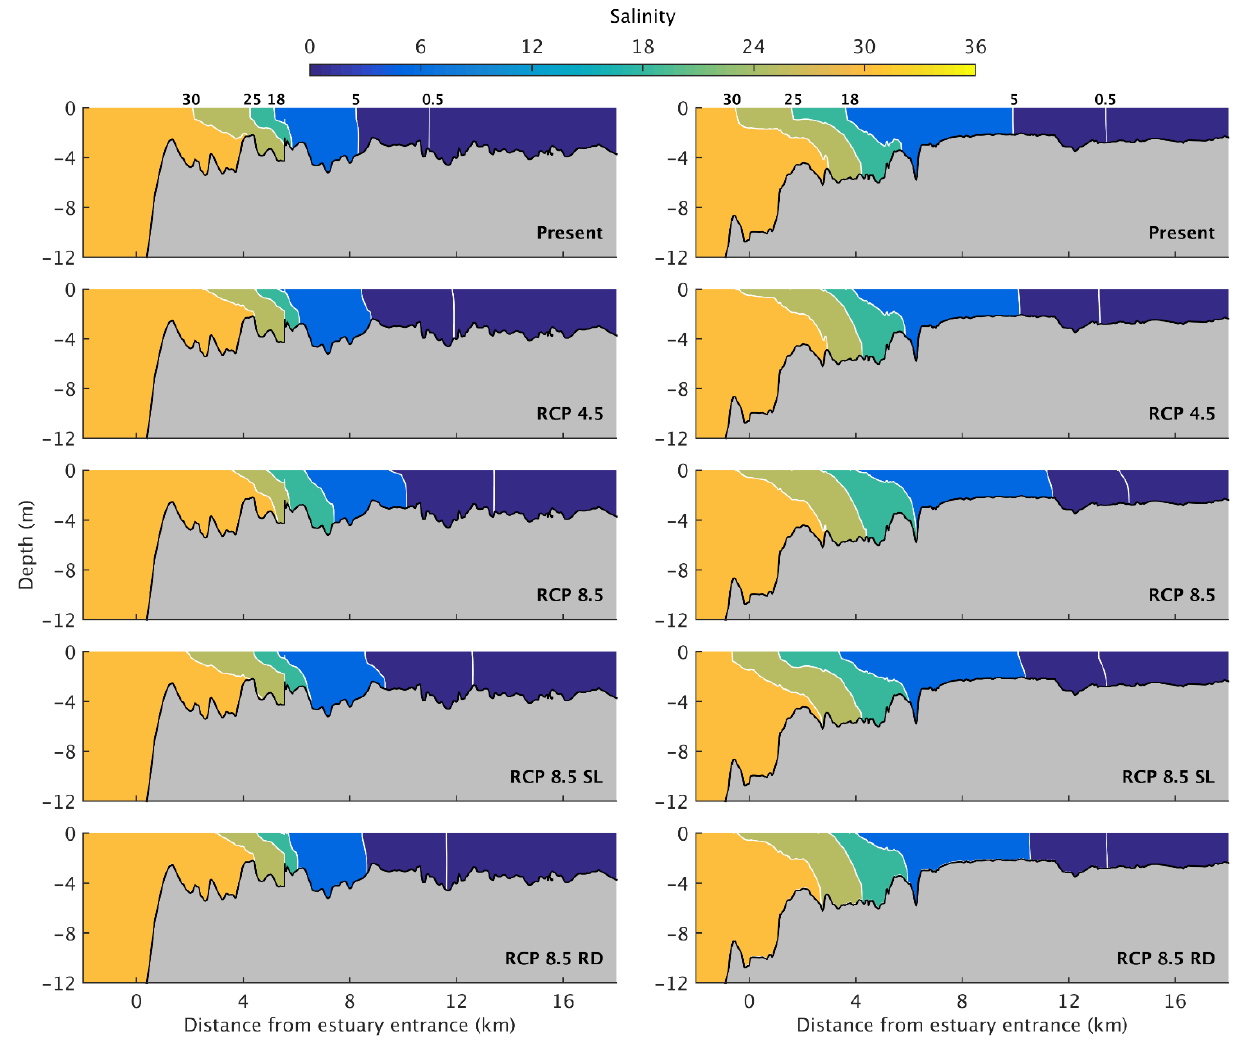
Figure 4. Longitudinal section of salinity distribution during winter conditions for the Present, RCP 4.5, and RCP 8.5 scenarios. The ( left ) panel represents the Minho estuary and the ( right ) panel the Lima estuary.